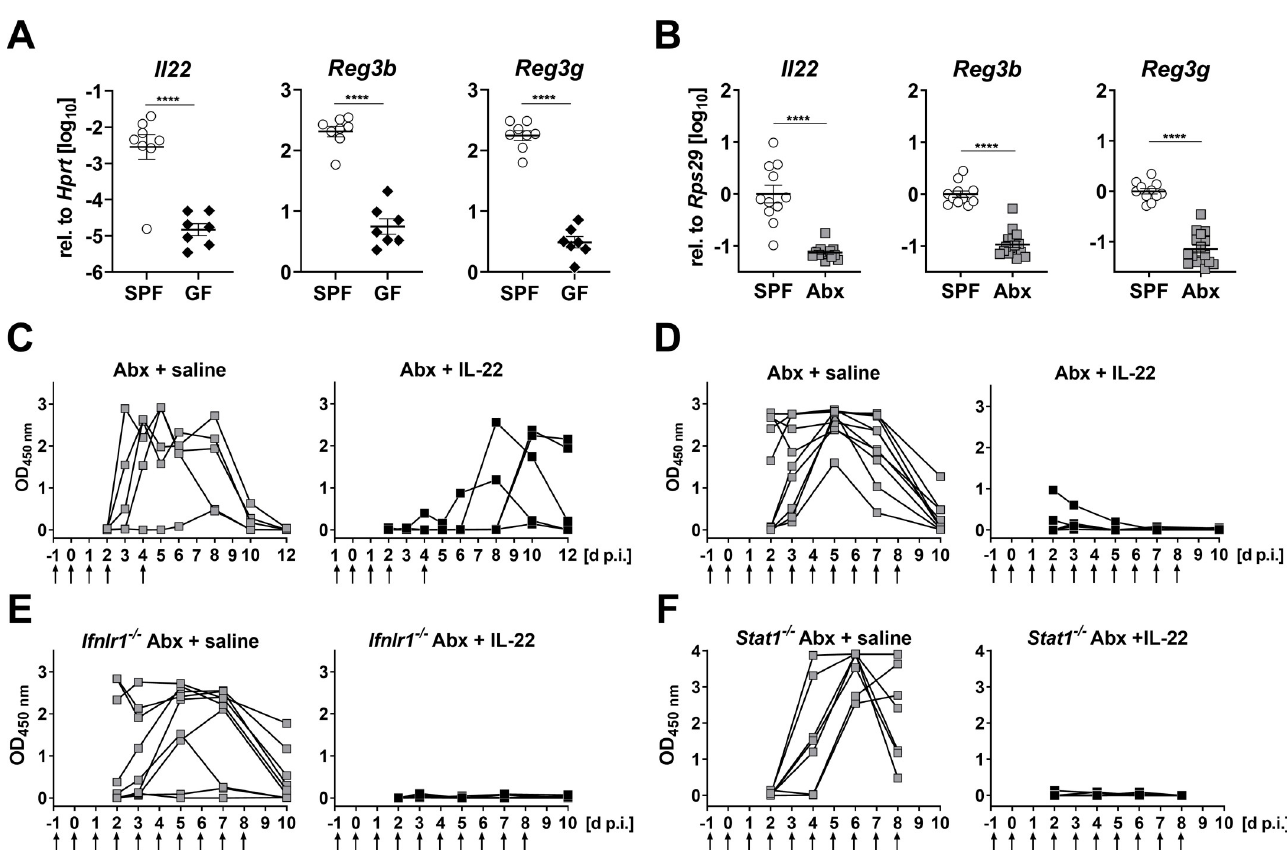
Fig 3. IL-22 confers short-lived rotavirus resistance in antibiotic-treated C57BL76 mice via a mechanism that is not dependent on IFN signaling. (A, B) RT- qPCR analysis of tonic expression of Il22 and IL-22-regulated genes Reg3b and Reg3g in enriched intestinal epithelial cell fractions of (A) germ-free (GF) or in ileum samples of (B) antibiotic-treated (Abx) mice compared to animals with undisturbed microbiota (SPF). (C, D) Antibiotic-treated WT mice were subjected to brief (n = 5) or extended (n = 10) IL-22 treatment regimens (1 μ g per injection, time points indicated by arrows) before infection with 2.4x10 4 ID 50 of murine rotavirus strain EDIM by oral gavage. Control animals (C, n = 5; D, n = 9) were treated with saline. Fecal pellets were collected at the indicated time points and viral antigen in the samples was quantified by ELISA. (E, F) Same experimental setup as in panel D, except that (E) Ifnlr1 -/- (saline n = 9; IL-22 n = 10) or (F) Stat1 -/- (saline n = 7; IL-22 n = 9) mice were used. Symbols represent individual mice, and bars in (A) and (B) represent means ± SEM. Statistical analysis: Unpaired t-test; ���� p <